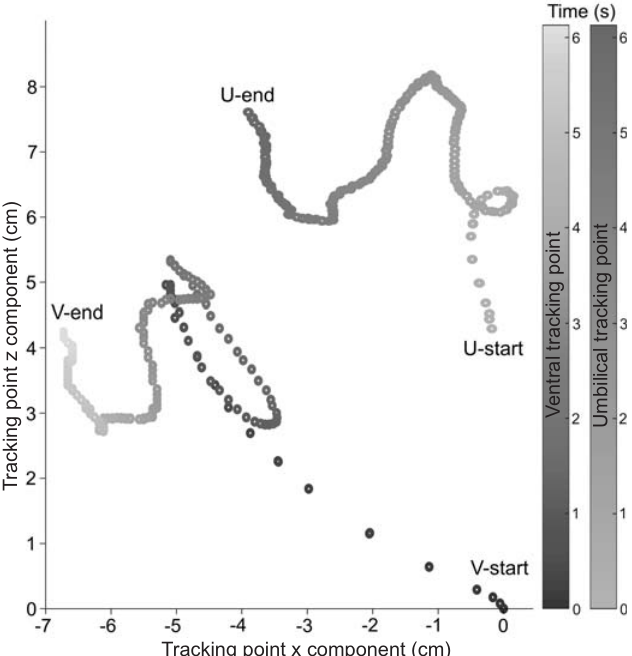
Fig. 5. Position of the ventral tracking point (V) and umbilical tracking point (U) as a function of time measured with the physics modeling soft- ware (Tracker 4.11.0; Brown 2017). Note that the rotation of the aperture is coupled with translational motion, resulting in complex movement.